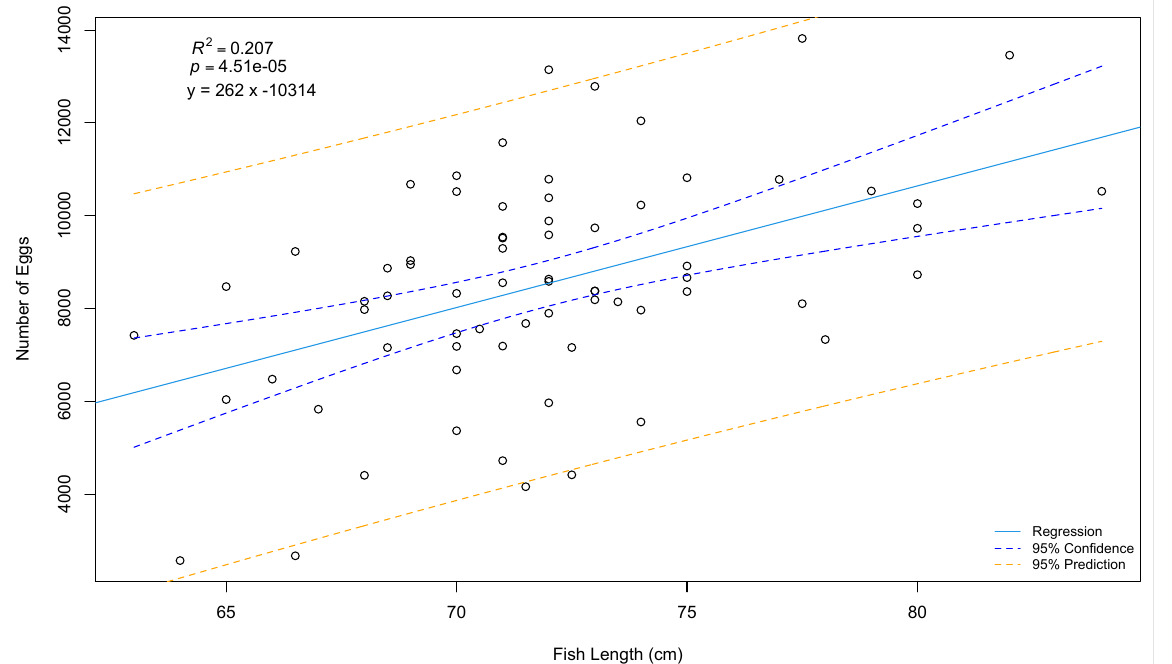
Figure 7. Regression of egg number over fish length (cm) recorded from 1999–2020 (unpublished data). Source: Merinov, Dupont-Cyr,